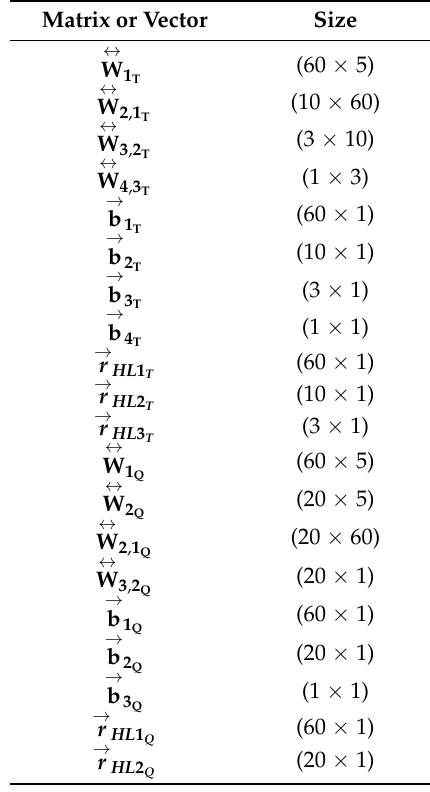
Table 5. Size of weight matrices, bias. vectors and hidden layers outputs. Matrix or